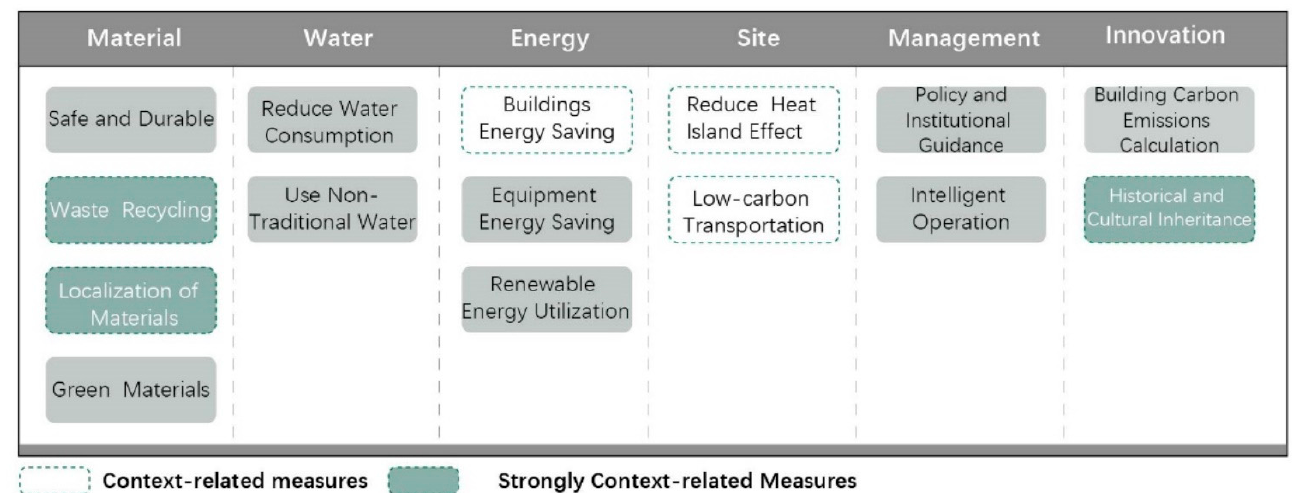
Figure 9. Context-related items of measures.